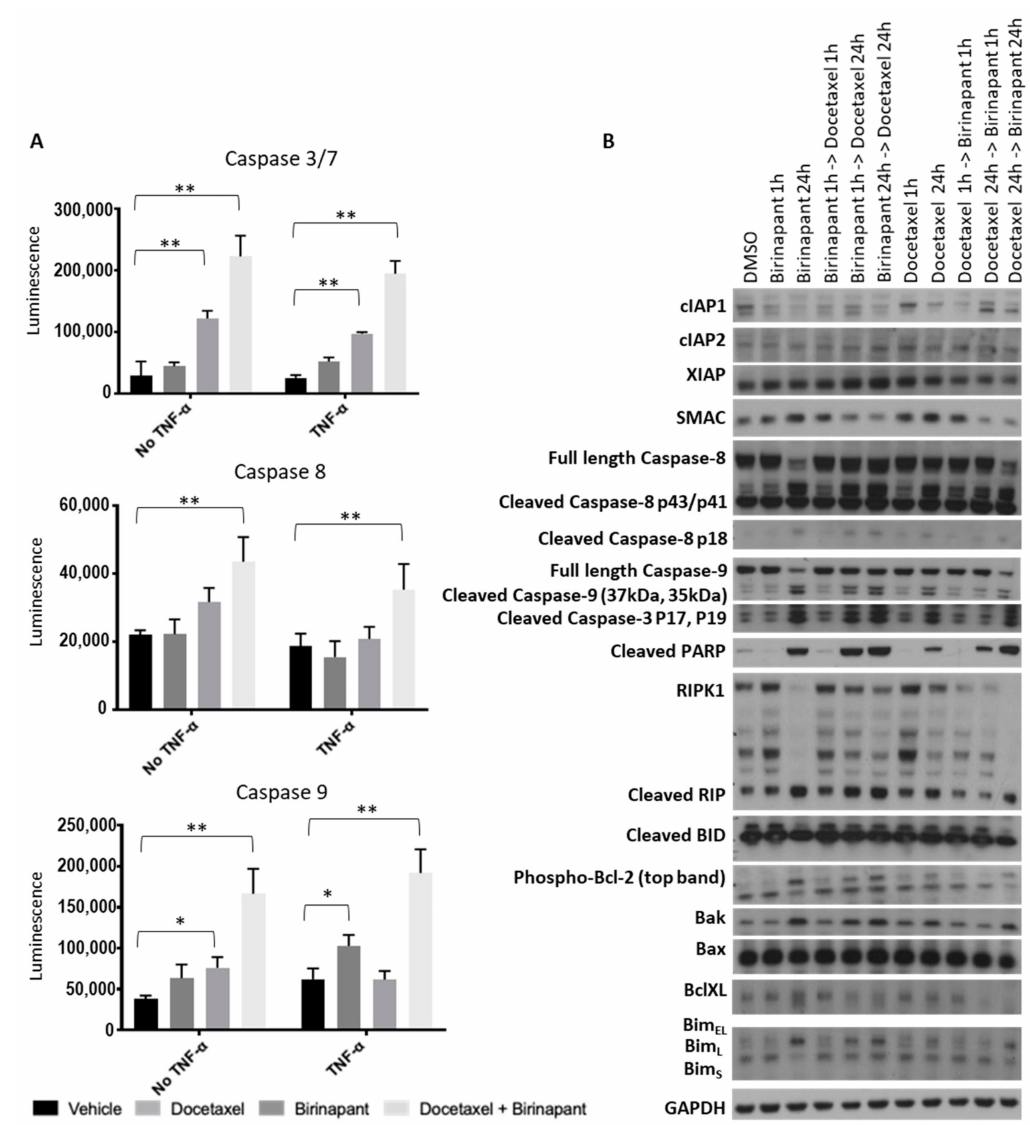
Figure 3. Docetaxel and birinapant synergistically increase cell death. ( A ) Caspase activation was quantified by luminescence assay as a surrogate for apoptotic activity. All luminescence data were normalized to cell viability as determined by XTT assay performed simultaneously. ANOVA multiple comparisons testing determined statistically significant results. * p < 0.005; ** p < 0.0001. Error bars indicate standard error of the mean. ( B ) Changes in apoptosis proteins were measured by western blot in CaOV3 after treatment with either single-agent or combination birinapant 200 and docetaxel 2.5 nM added sequentially or concurrently and with varying time points (1 vs. 24 h) as